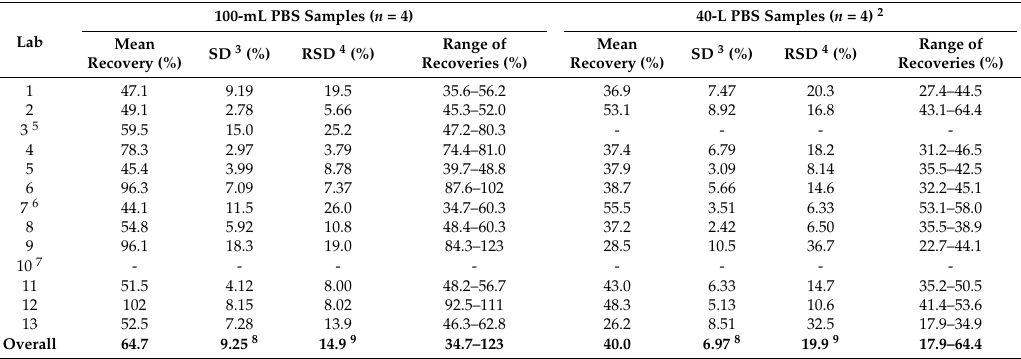
Table 2. Summary of MS2 recoveries for spiked, 100-mL and 40-L PBS samples analyzed using EPA Method 1602 and EasyPhage 1 .